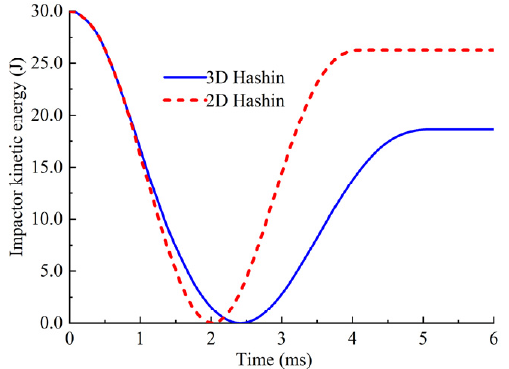
Figure 13. Kinetic energy variation of the impactor.